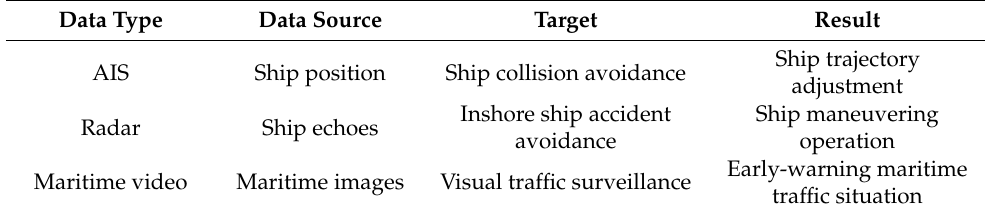
Table 1. Overview of the previous work related to ship